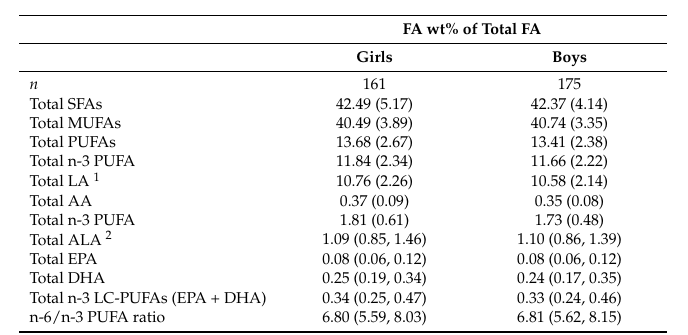
Table 2. Breast milk fatty acid composition. Values are wt% FA of total FA, presented as mean (SD) if normally distributed, otherwise as median (IQR).